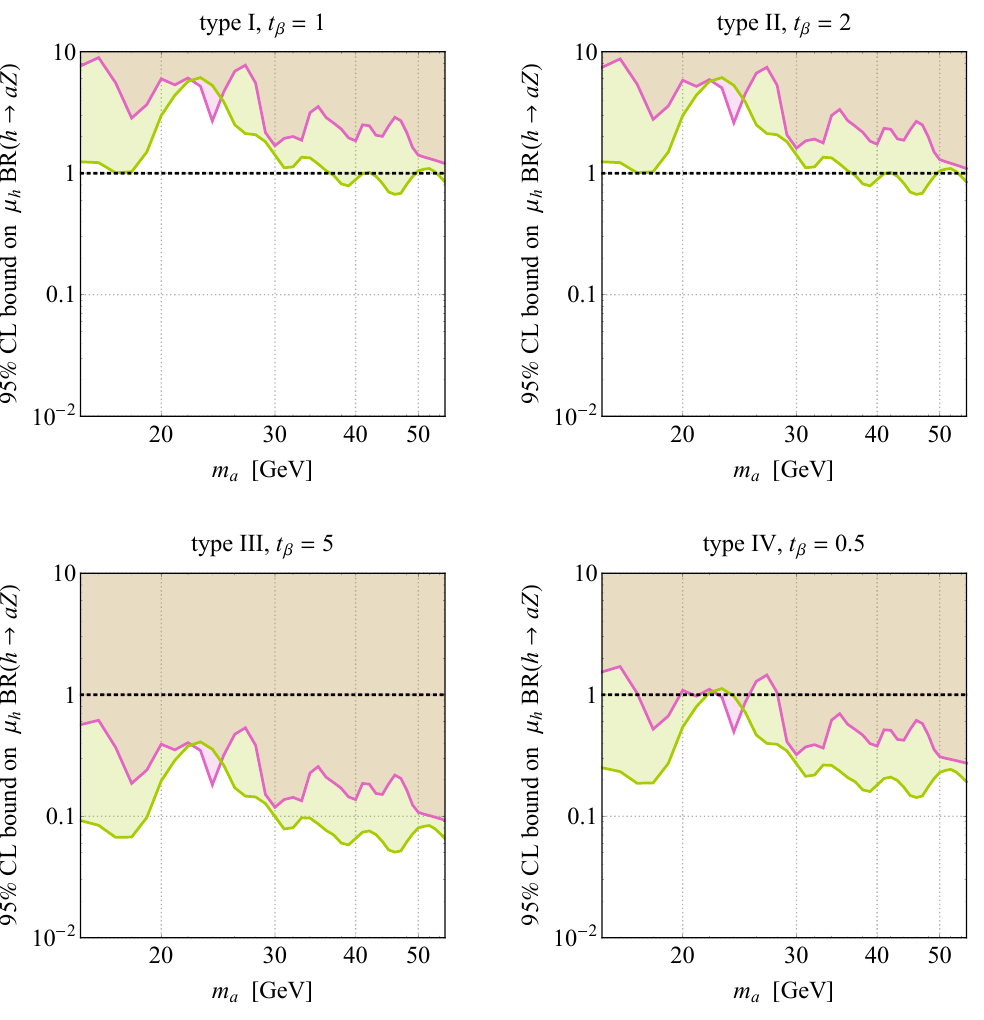
Figure 2 . Limits on (cid:22) h BR( h ! aZ ) in the 2HDM+S of type I with t (cid:12) = 1 (top left), type II with t (cid:12) = 2 (top right), type III with t (cid:12) = 5 (bottom left) and type IV with t (cid:12) = 0 : 5 (bottom right). The red and green bounds correspond to the ATLAS search for pp ! h ! Z d Z ! 4 ‘ [22] and pp ! h ! Z d Z ! 2 (cid:22) 2 ‘ [23], respectively. The dashed black lines indicate (cid:22) h BR( h ! aZ ) = 1 and all coloured regions are excluded at 95%